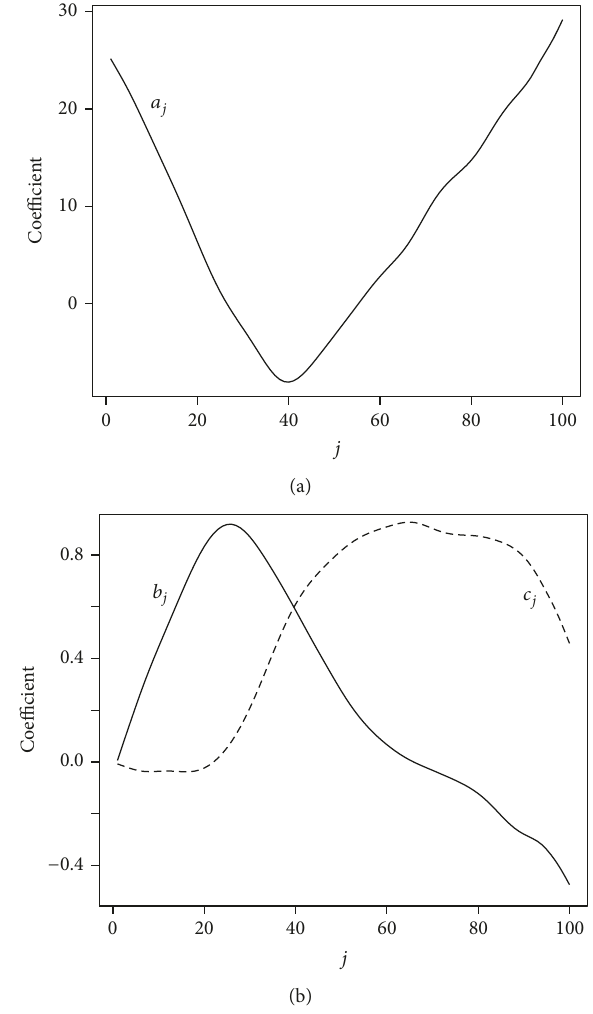
Figure 7: Estimates of multiple regression coefficients 𝑎 𝑗 (a), 𝑏 𝑗 (solid line in (b)), and 𝑐 𝑗 (broken line in (b)). The predictive value of the diameter 𝑑 ∗ 𝑗 at point 𝑗 is obtained by 𝑑 ∗ 𝑗 = 𝑎 𝑗 + 𝐷 ∗ (105.0)+𝑐 𝐷 ∗ (255.0) . The diameter at 𝑥 = 105.0 mm positively 𝑏 𝑗 𝑗 and negatively affected the prediction in the range of 𝑗 = 1,...,50 and 70,...,100 , respectively. Another diameter at 𝑥 = 255.0 mm contributed to the estimate for the range of 𝑗 = 50,...,90